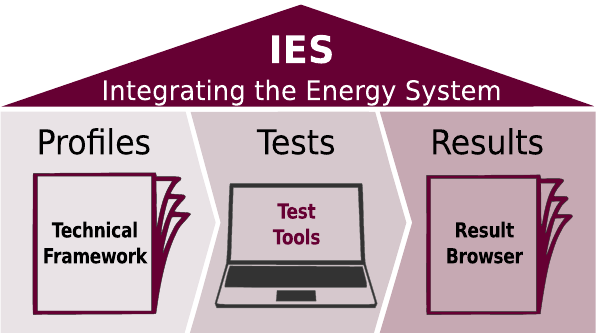
Figure 15. The three pillars of the IES approach: identification and specification, peer-to-peer testing, public available specifications and results (Open Access).